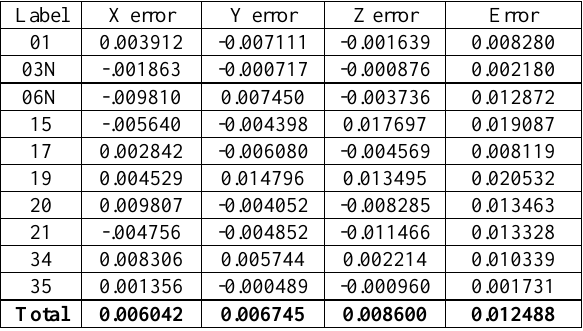
Table 3. Ground Control Point location errors (m)